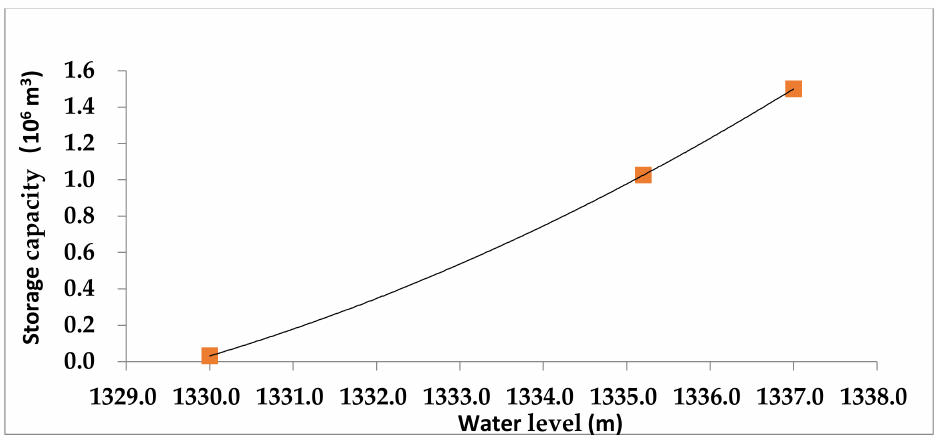
Figure 7. Barrier lake water level versus storage